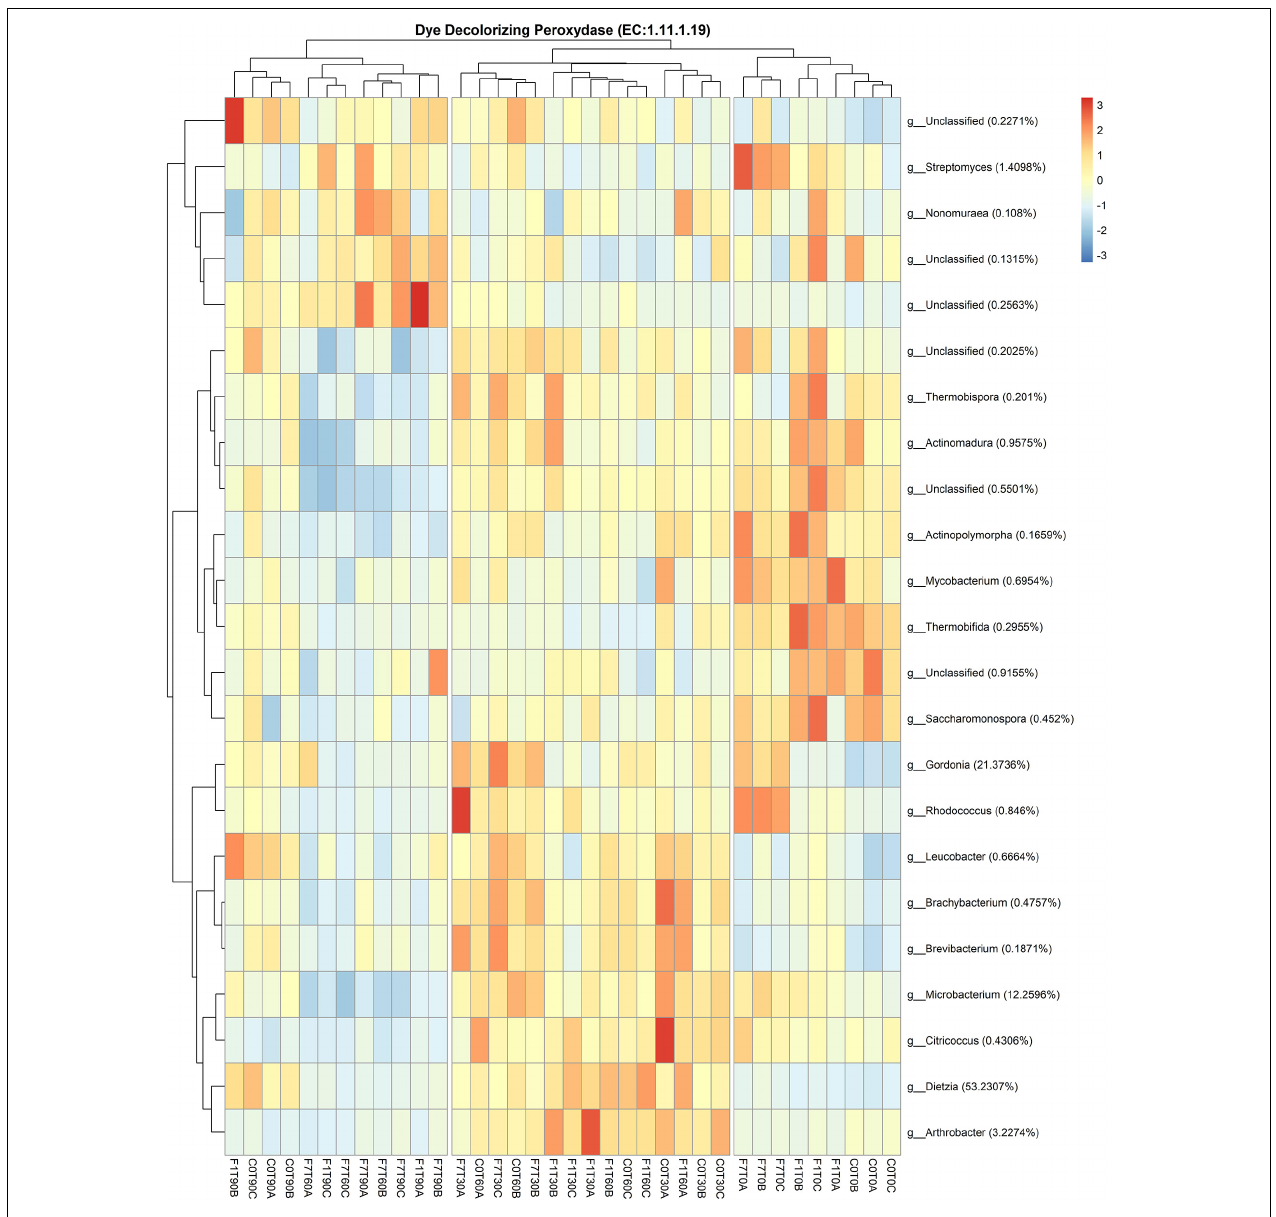
FIGURE 11 | Heatmap showing Bacterial contribution to Dye decolorizing peroxidase (EC:1.11.1.19) in metagenome, as calculated by PICRUSt 2. Reported taxonomic resolution is genus level, with a cut-off of 0.1%. Hierarchical clustering was performed on both rows and columns by Pearson correlation, based on Euclidean distance. Colour scheme represents row-wise Z-scores of contribution counts per ASV. Percentage reported near ASV names represent the relative abundance of the sum of ASV contributions per sample against total sum (i.e. Z = 0 matches reported percentage). Unclassified ASV contribution were not